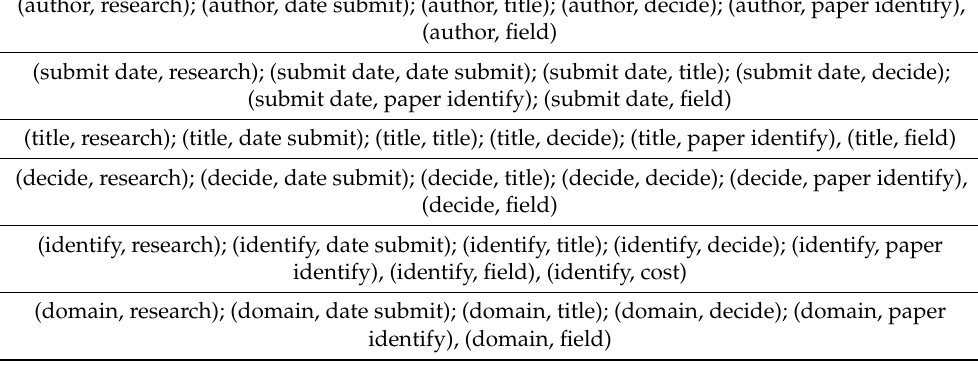
Table 6. Cartesian product of properties.